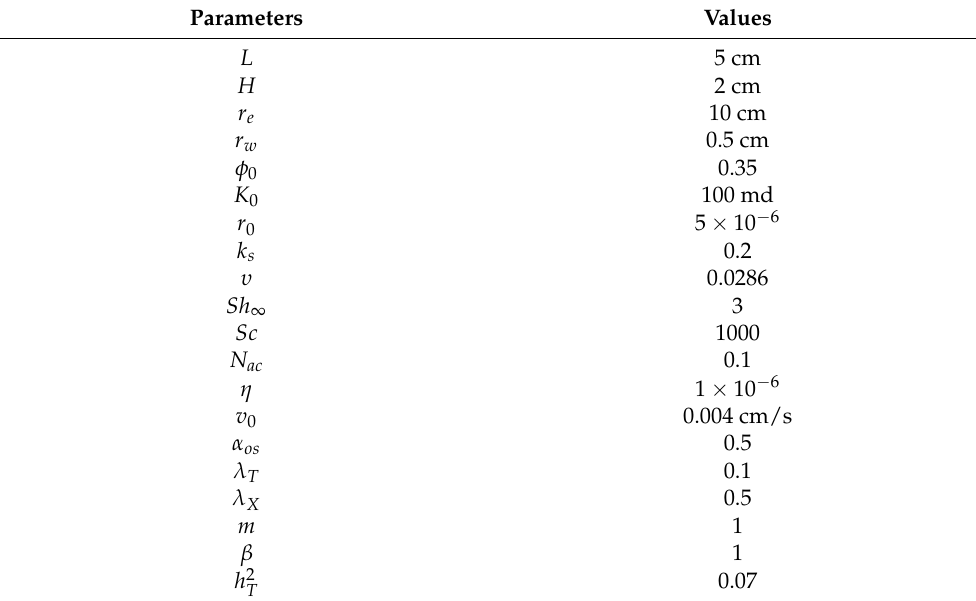
Table 1. List of values of parameters used in the